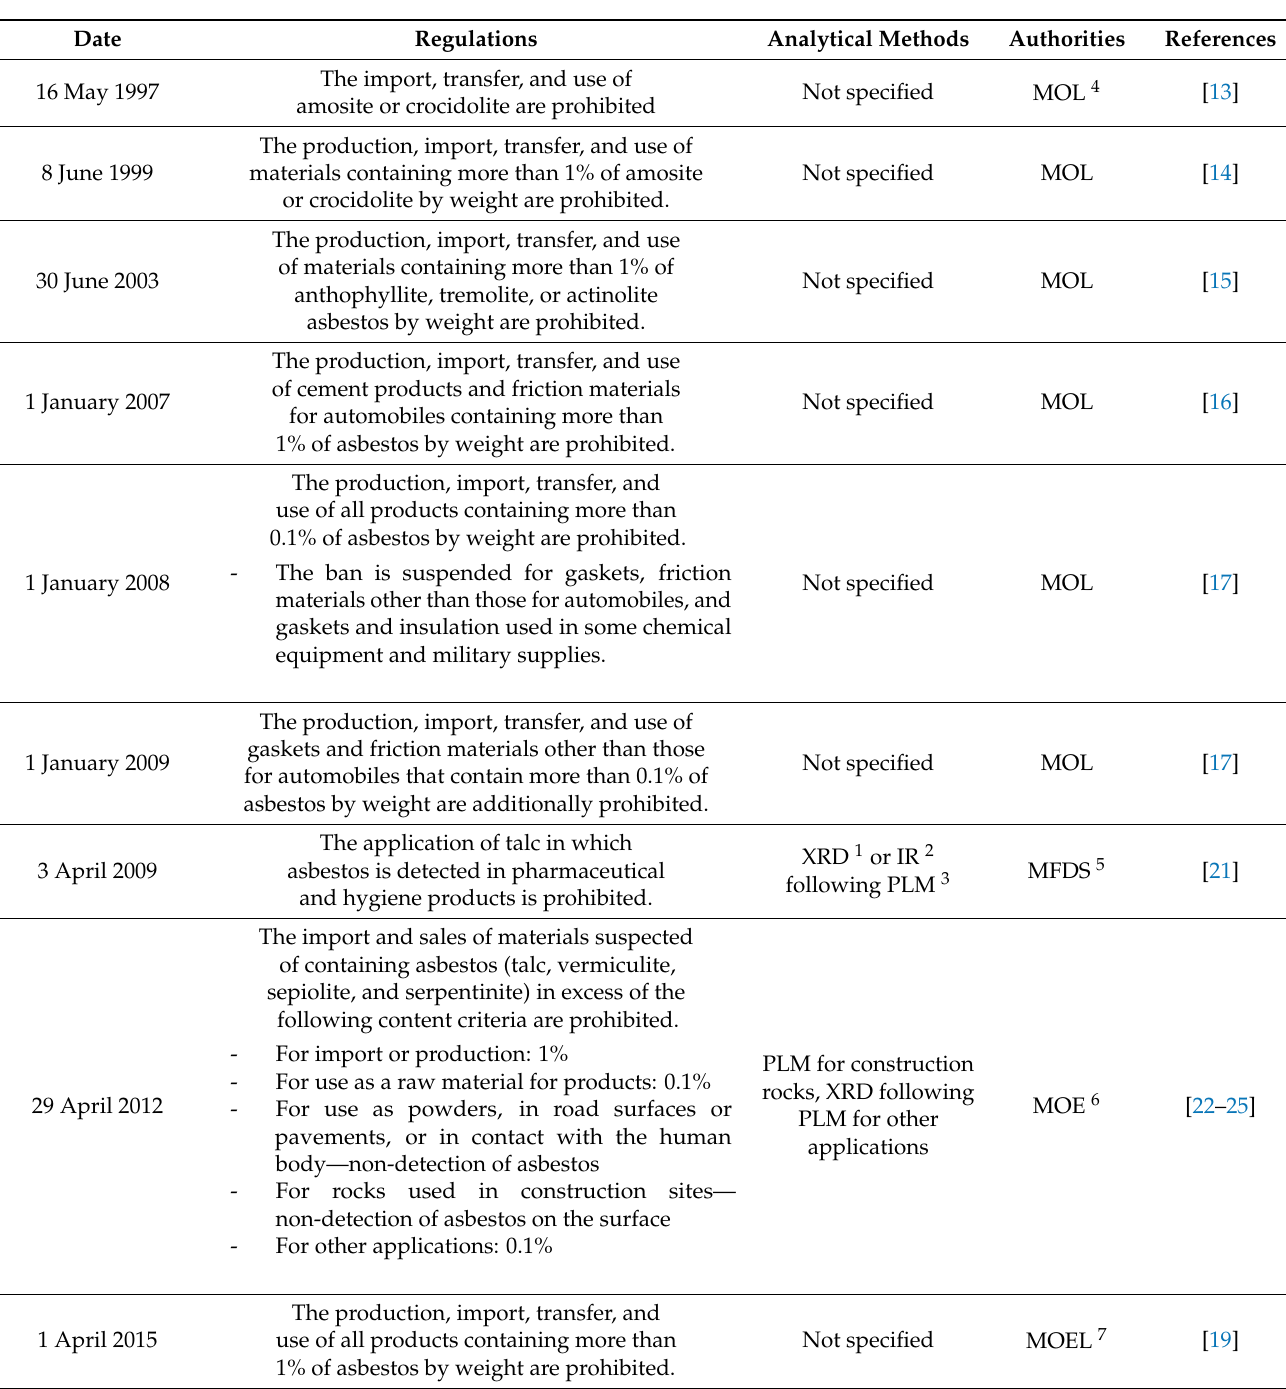
Table 1. Regulations for asbestos bans in